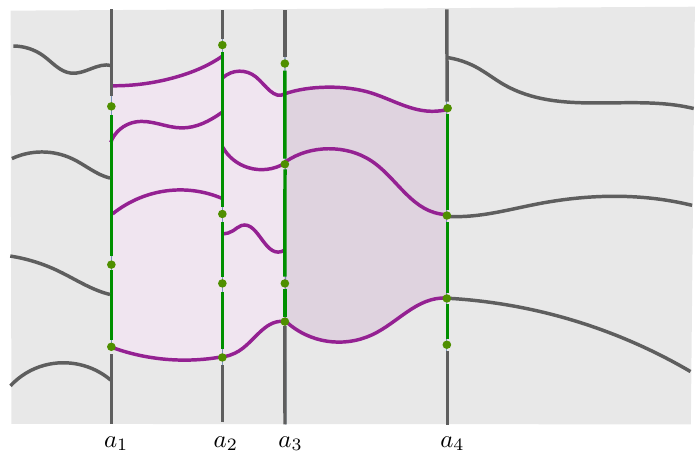
Figure 5 . A definable cylindrical cell decomposition of R 2 build from the decomposition in figure 4. The new R 2 -cells are graphs and bands of definable functions on the R -cells. The new cells